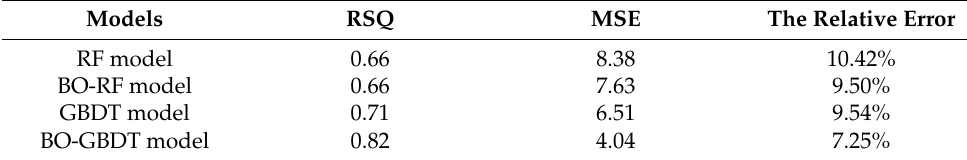
Table 4. Error parameters of the